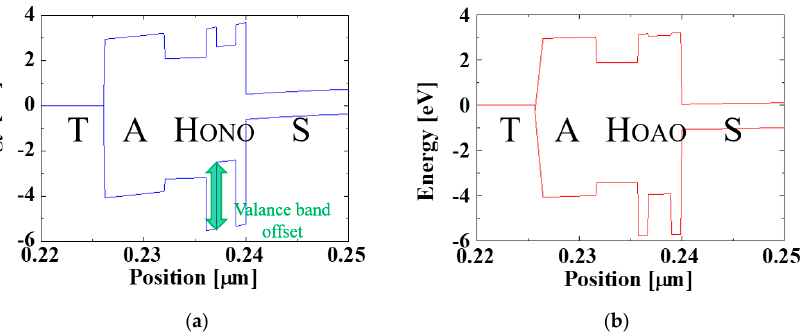
Figure 8. Energy band diagram of ( a ) BE-TAHOS, and ( b ) proposed TAHOAOS structure. Regarding retention characteristics, the valence band offset of BE-TAHOS (green arrow in panel a) mitigates the advantage of thicker tunneling oxide layers in BE-TAHOS. The abbreviated letters T, A, H, O, N stand for tantalum nitride (TaN, gate metal), Al 2 O 3 , HfO 2 , SiO 2 , Si 3 N 4 , respectively.